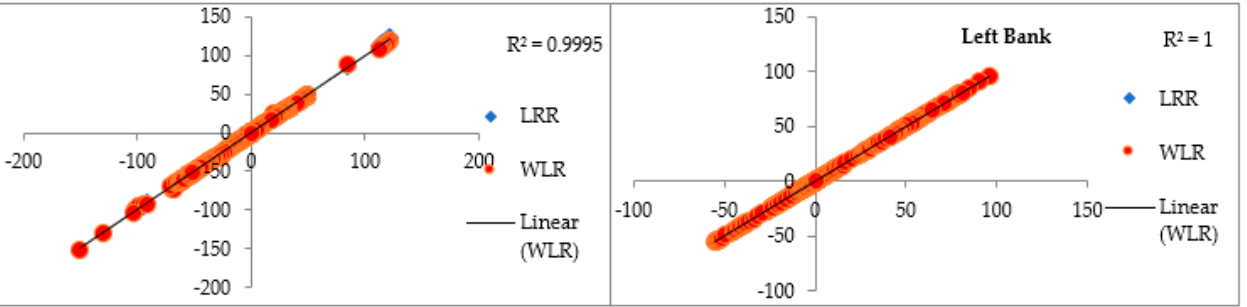
Figure 10. Standard error for LRR and WLR.